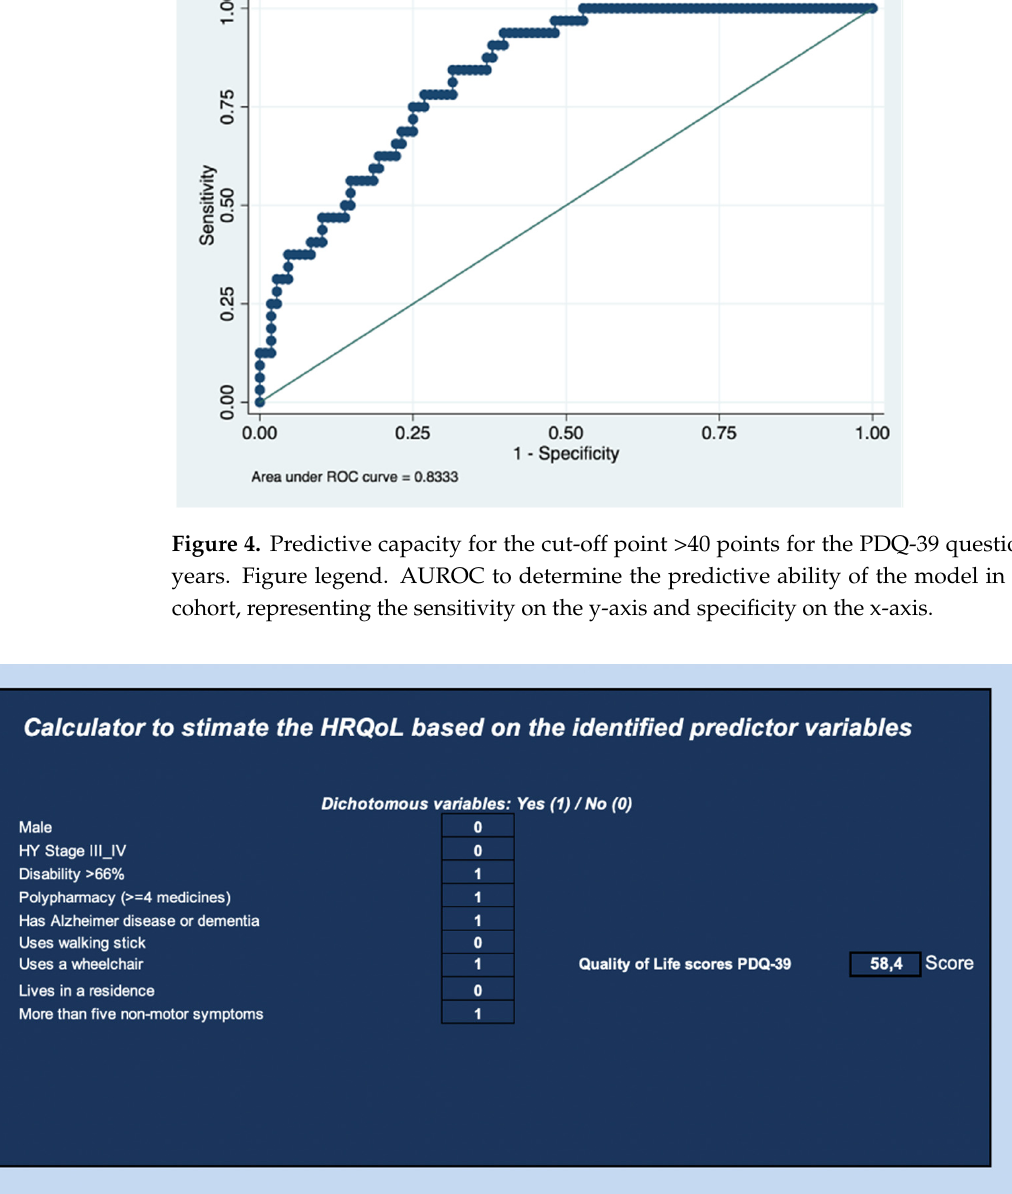
Figure 3. Predictive capacity for the cut-off point >40 points for the PDQ-39 questionnaire at one year. Figure legend. AUROC to determine the predictive ability of the model in the validation co- hort, representing the sensitivity on the y-axis and specificity on the x-axis.